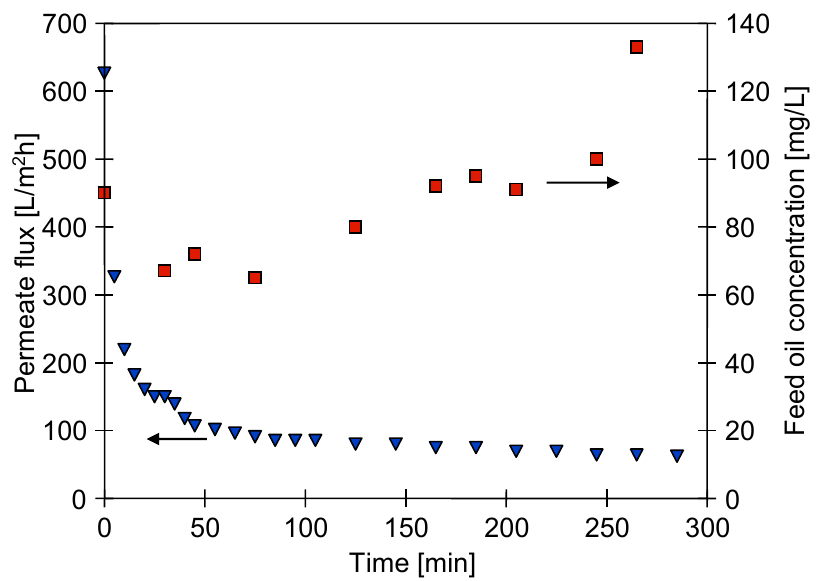
Figure 12. Variations in permeate flux and oil concentration in the feed during MF of oily wastewater #1. Module MF1, TMP = 0.05 MPa, T = 22 °C, v F = 0.5 m/s.